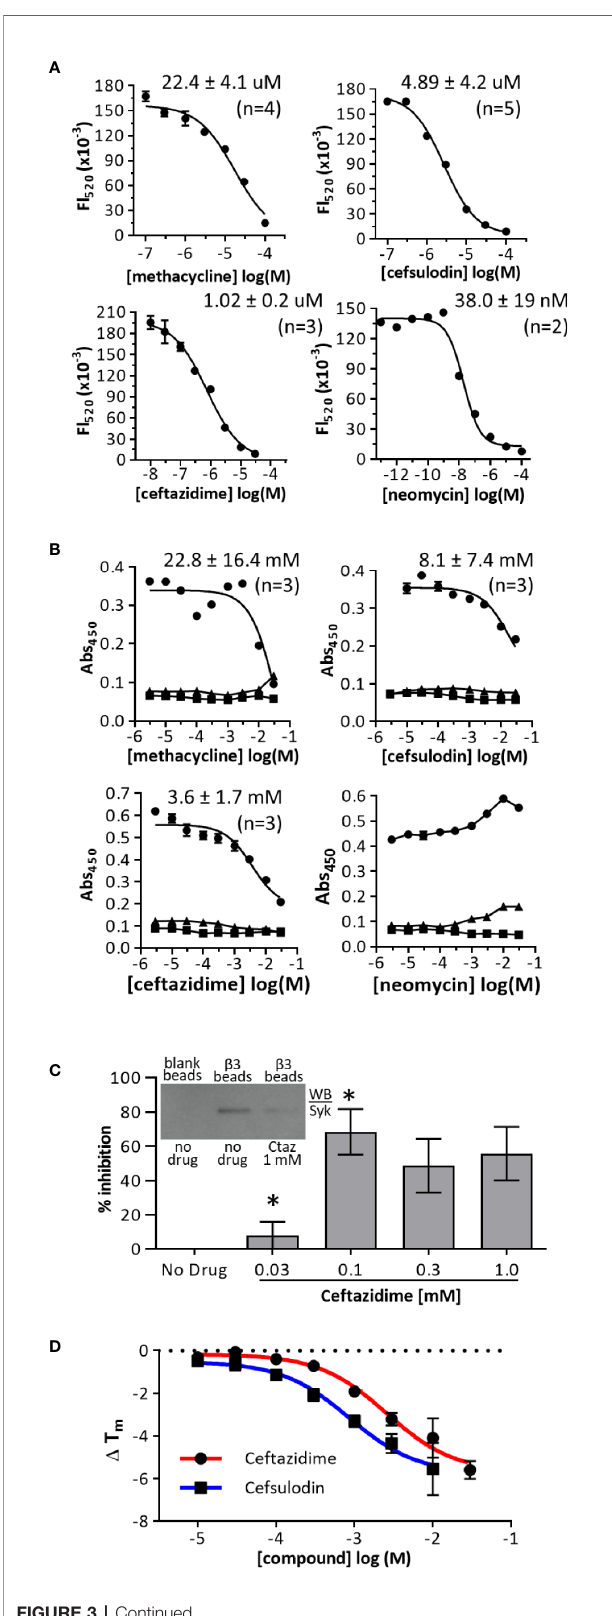
FIGURE 3 | Dose-response curves in primary and orthogonal screens. (A) AlphaScreen dose-response curves. Biotinylated-b3(sh) peptide was used at a fi nal concentration of 30 nM, and GST-Syk(6-370) was used at a fi nal concentration of 0.3 nM. Data are expressed as mean fl uorescence (Fl 520 ) ± range from duplicates, and one representative experiment of “ n ” performed is shown. (B) Orthogonal ELISA-based dose-response assays. Biotinylated-b3 (long) peptide was used at a coating concentration of 1 µg/ml, and GST-Syk (6-370) was used at a fi nal concentration of 0.3 nM ( ○ ); GST only ( ▪ ); no b 3 (black D ). Data are expressed as mean abs 450 ± SEM from triplicate determinations, and one of three representative experiments is shown. (C) Ceftazidime inhibition of b 3 peptide binding to Syk from THP-1 whole cell lysate. THP-1 cell lysate (100 ug) was treated with or without ceftazidime (Ctaz) before incubation with b 3-coated avidin-agarose beads, and bound Syk was measured by western blot (example shown in inset). Blank beads served as a negative control. Equal b 3 peptide loading was veri fi ed by probing blots with avidin-HRP (not shown). Data were quanti fi ed as mean percent inhibition ± SEM (n = 3). *p < 0.01 (Tukey post-hoc comparison) (D) Thermal denaturation curves of GST-Syk(6-370). GST-Syk(6-370) was used at a concentration of 2 µM, and denaturation was measured via SYPRO Orange